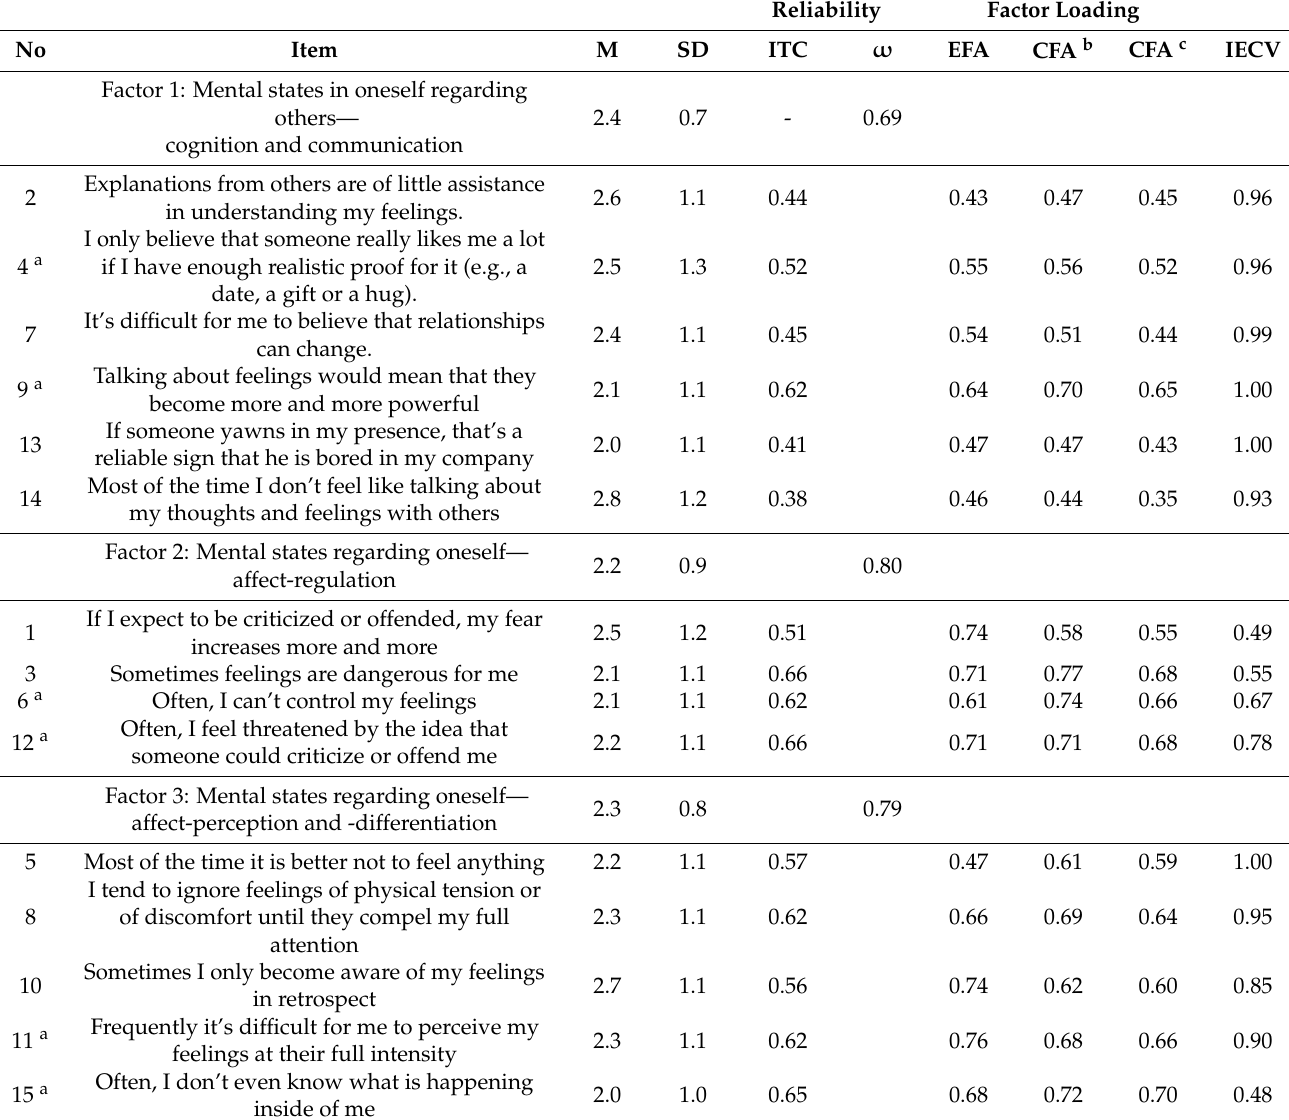
Table 2. Psychometric properties and factorial structure of the MZQ and MZQ-6 short scale. Reliability Factor